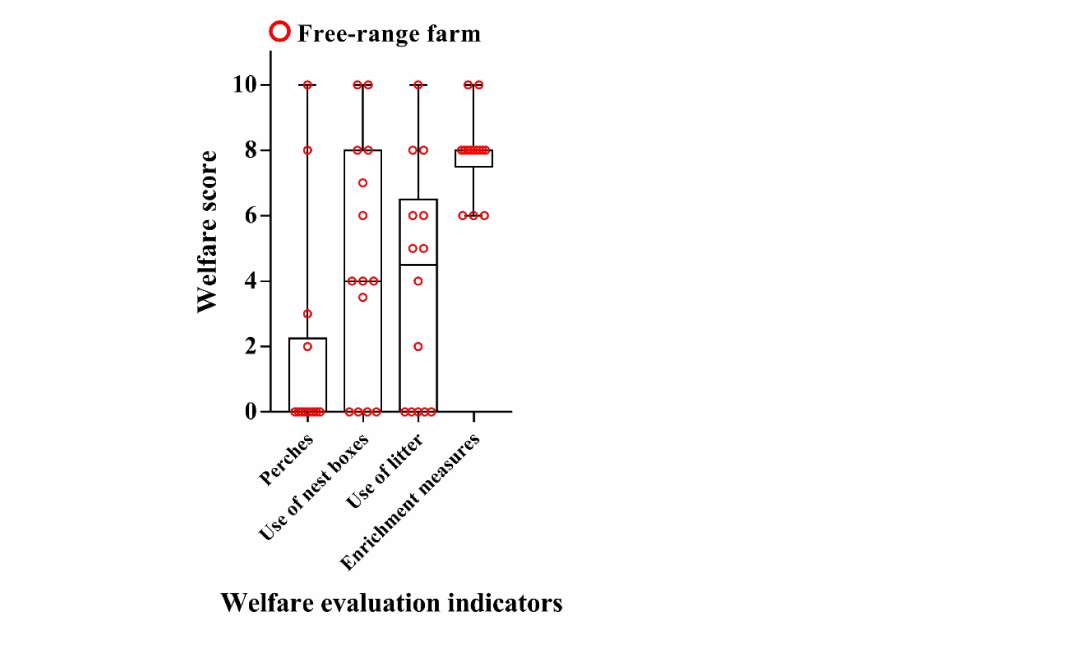
Figure 4. Scores for welfare indicators found only on free-range egg production farms.